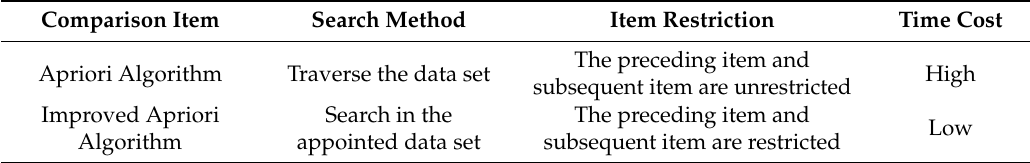
Figure 4. The flowchart of the improved Apriori algorithm. Table 4. Comparison between ‘Improved Apriori Algorithm’ and ‘Apriori algorithm’.